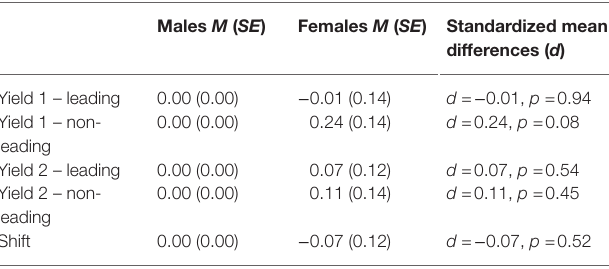
TABLE 8 | Latent means of males and females for the latent GSS 1 factors and the standardized mean difference